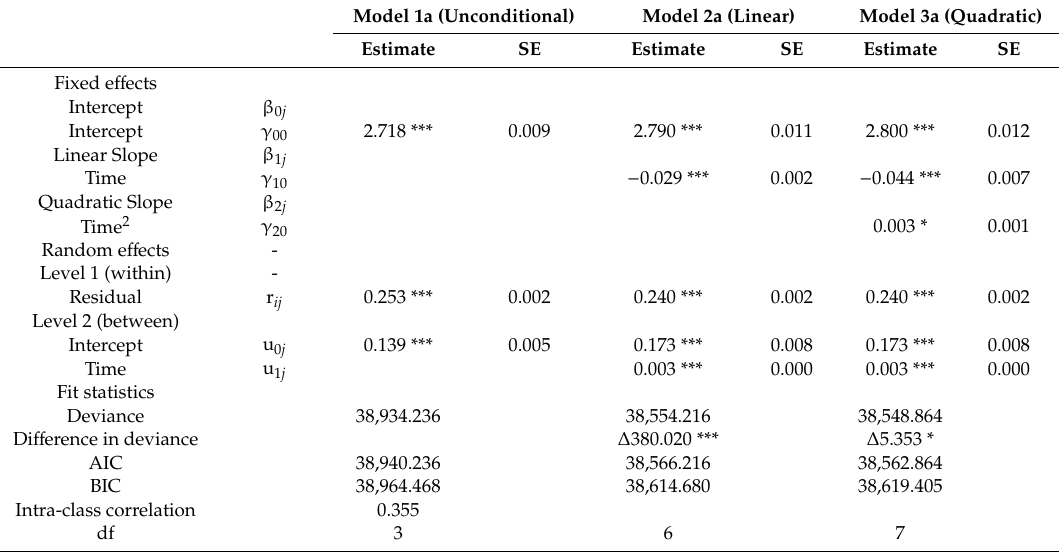
Table 3. Results of IGC models for parental behavioral control (Wave 1–6).